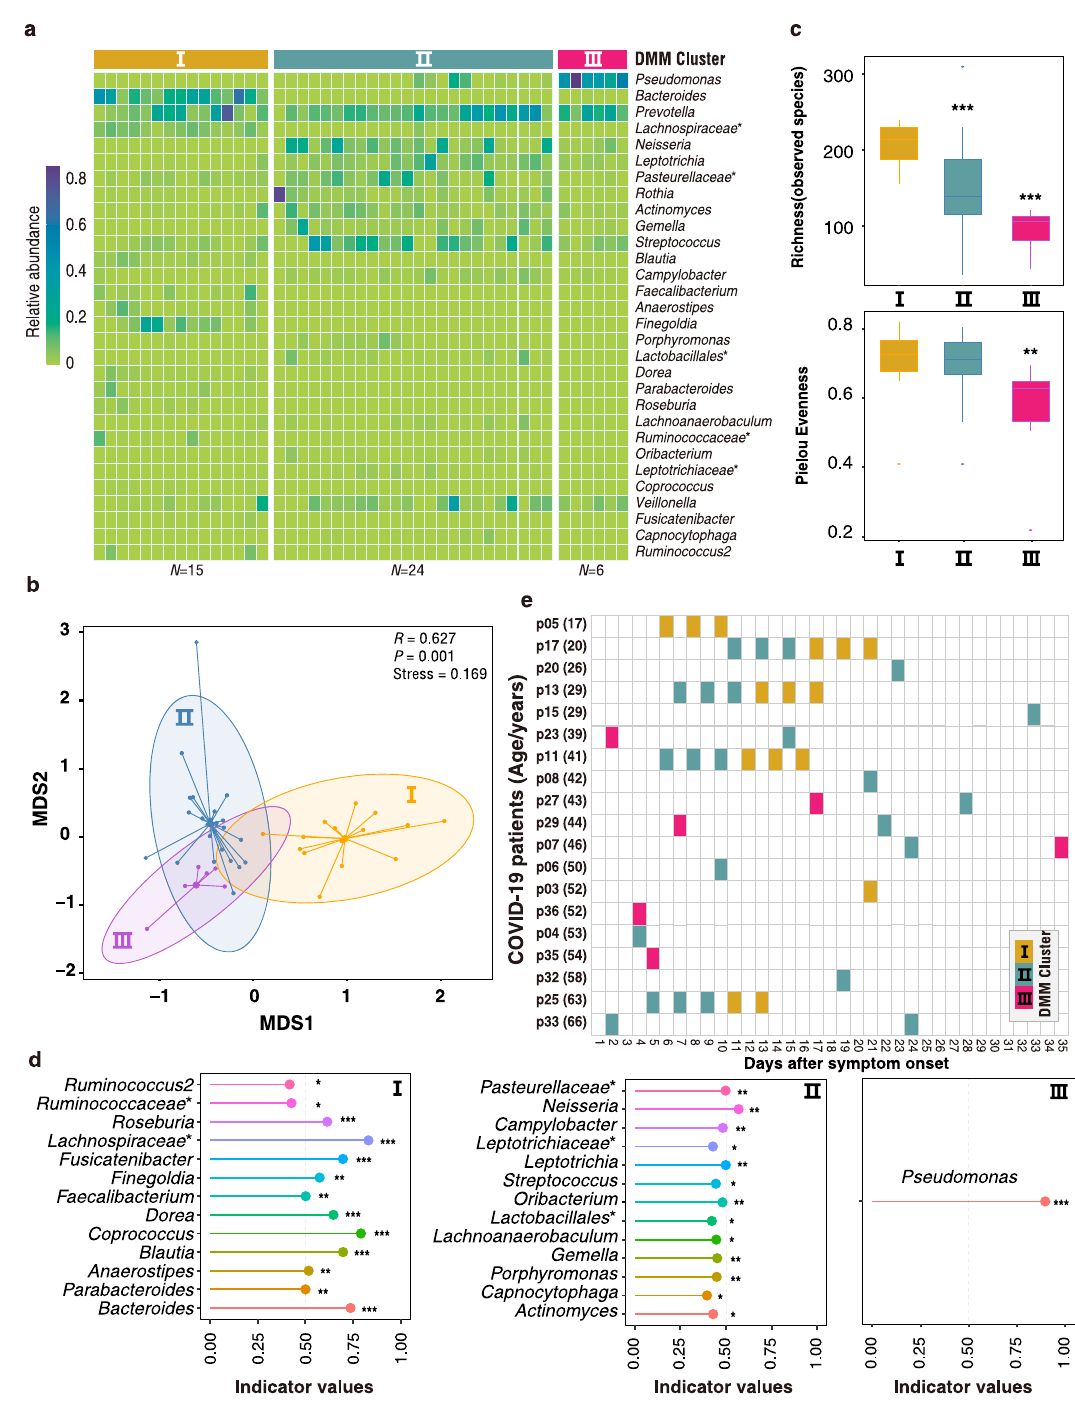
Fig. 2 DMM clustering of 16 S rRNA gene-sequencing data of gut microbiota ( N = 45). Dirichlet multinomial mixtures (DMM) modelling was applied to 16 S rRNA gene sequencing. The entire dataset formed three distinct clusters based on lowest Laplace approximation. All samples were collected from COVID-19 patients. Bacterial taxa marked by the stars represent unclassi fi ed bacteria genera. a Heatmap showing the relative abundance of the 30 most dominant bacterial genera per DMM cluster. b Nonmetric multidimensional scaling (NMDS) visualization of DMM clusters using Bray – Curtis distance of gut bacterial genera. The ANOSIM statistic R closer to 1 with <0.05 P- value suggest signi fi cant separation of microbial community structures. The stress value that was lower than 0.2 provides a good representation in reduced dimensions. c Boxplots showing the alpha-diversity (richness and evenness) per each DMM cluster. d Indicators of gut microbial community types (DMM clusters) identi fi ed from top 30 genus contributing to gut microbial community typing (DMM clustering) in a . * P < 0.05, ** P < 0.01, and *** P < 0.001. e Dynamic shift of gut microbial community types (DMM clusters) in different COVID-19 stages. Empty boxes indicate samples were unavailable in COVID-19 patients. Ages (years) were shown in parenthesis.